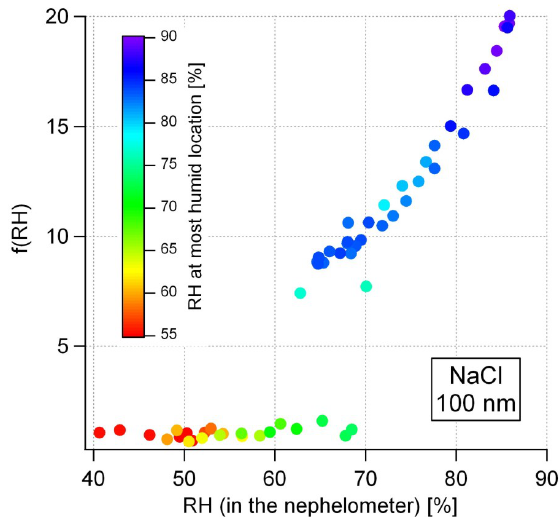
Fig. 2. f (RH) vs. RH of sodium chloride particles with a dry diameter of 100 nm, at λ =550 nm. The phase transition at deliquescence occurred at about RH=75% at the most humid location in the system (RH 3 ), as shown with the color scale.